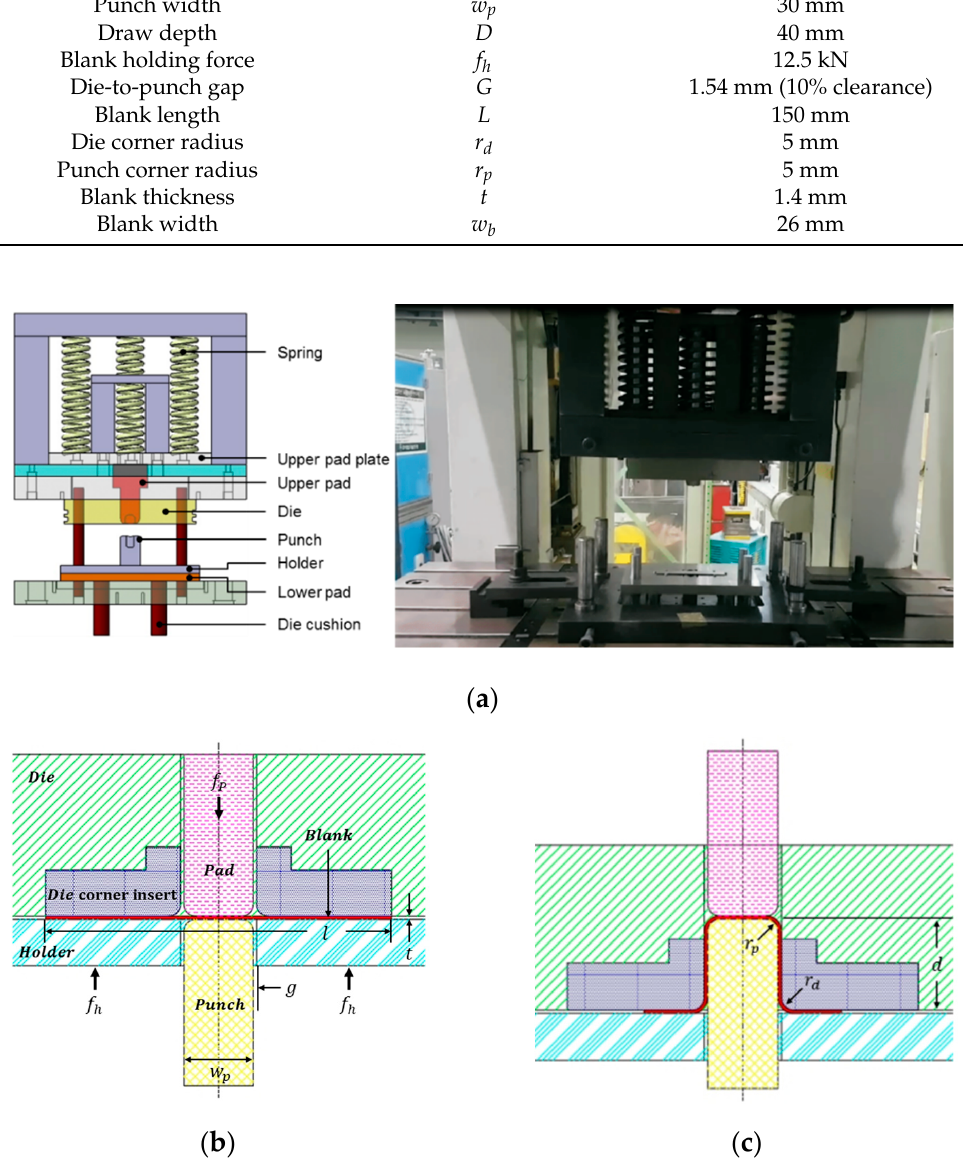
Figure 12. Experimental setup and schematic diagrams of the drawing wear test: ( a ) drawing wear test; ( b ) initial setup for the drawing test; ( c ) after forming stroke.